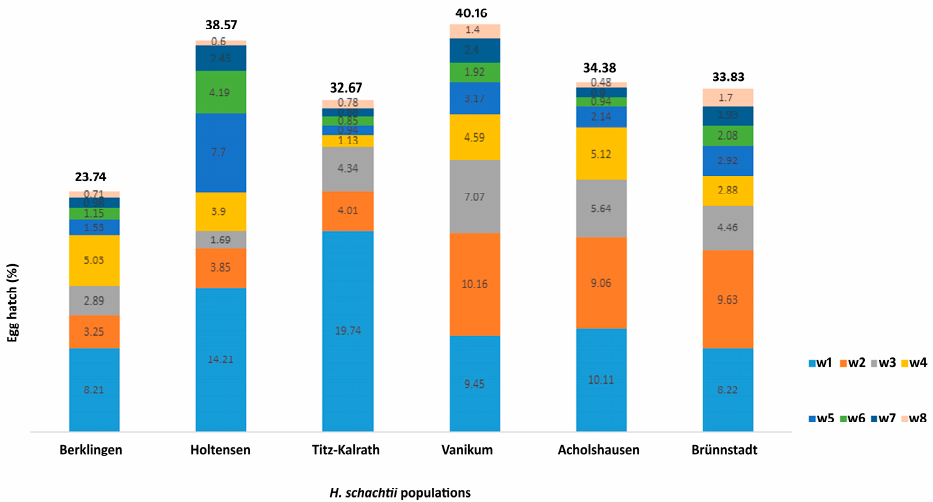
Figure 1. Egg hatching percentages of H. schachtii populations in zinc chloride solution over eight weeks. Each color represents the percentage ratio of J2 collected in the corresponding week to the egg content of 500 cysts. The percentage above each column refers to the total hatch percentage for each population during the eight weeks.